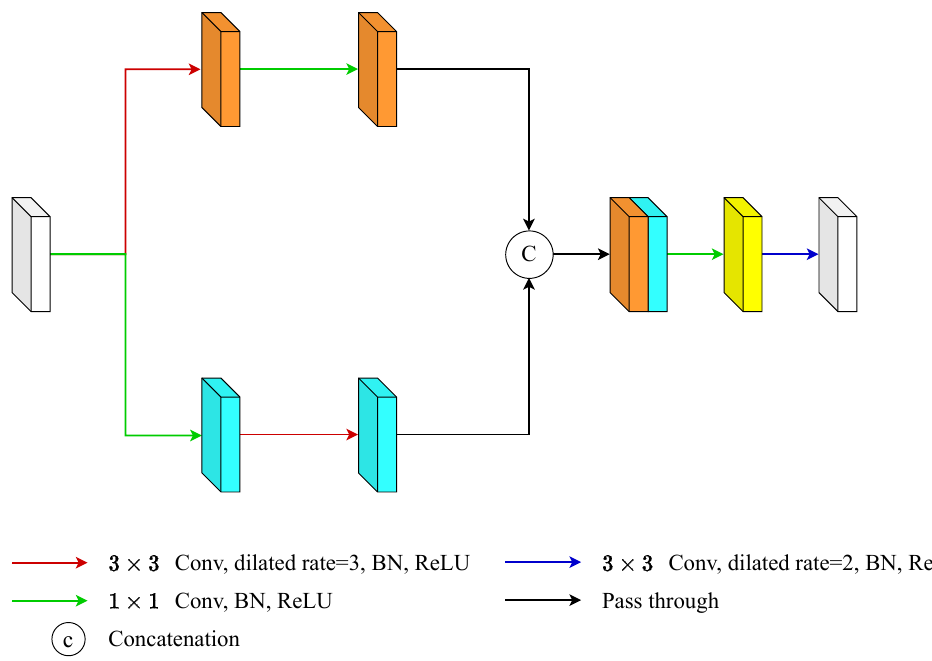
Figure 3. An illustration of global-modelling attention (GA). GA generated long-range relationships through two branches. The upper branch was aimed at capturing long-range context information and the lower branch was aimed at grabbing local context information. Then, this information is integrated by a series of